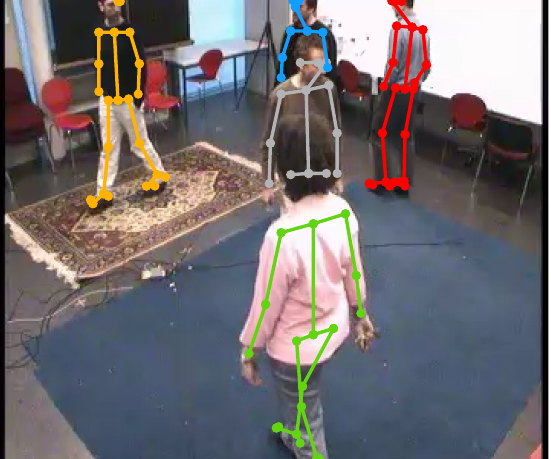
Figure 3. The estimated poses in frame 1824 of the EPFL-MPV dataset scene 6p-c0. Three out of five people are detected correctly (red, orange, and green poses) whereas the rest are not due to partial occlusion and missing data (gray and blue